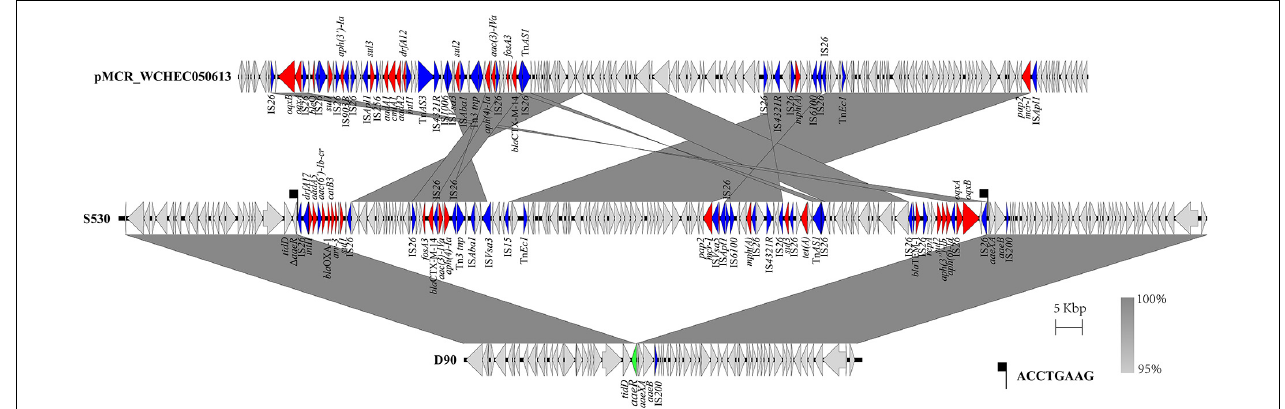
FIGURE 4 | Scaled, linear diagrams comparing the sequences between S530, D90 (GenBank no. CP022450), and pMCR_WCHEC050613 (GenBank no. CP019214). Antibiotic resistance genes are indicated in red arrows. The inserted gene aaeR is marked as the green arrow. Blue arrows denote transposon- and integron-associated genes. Other genes are shown as gray